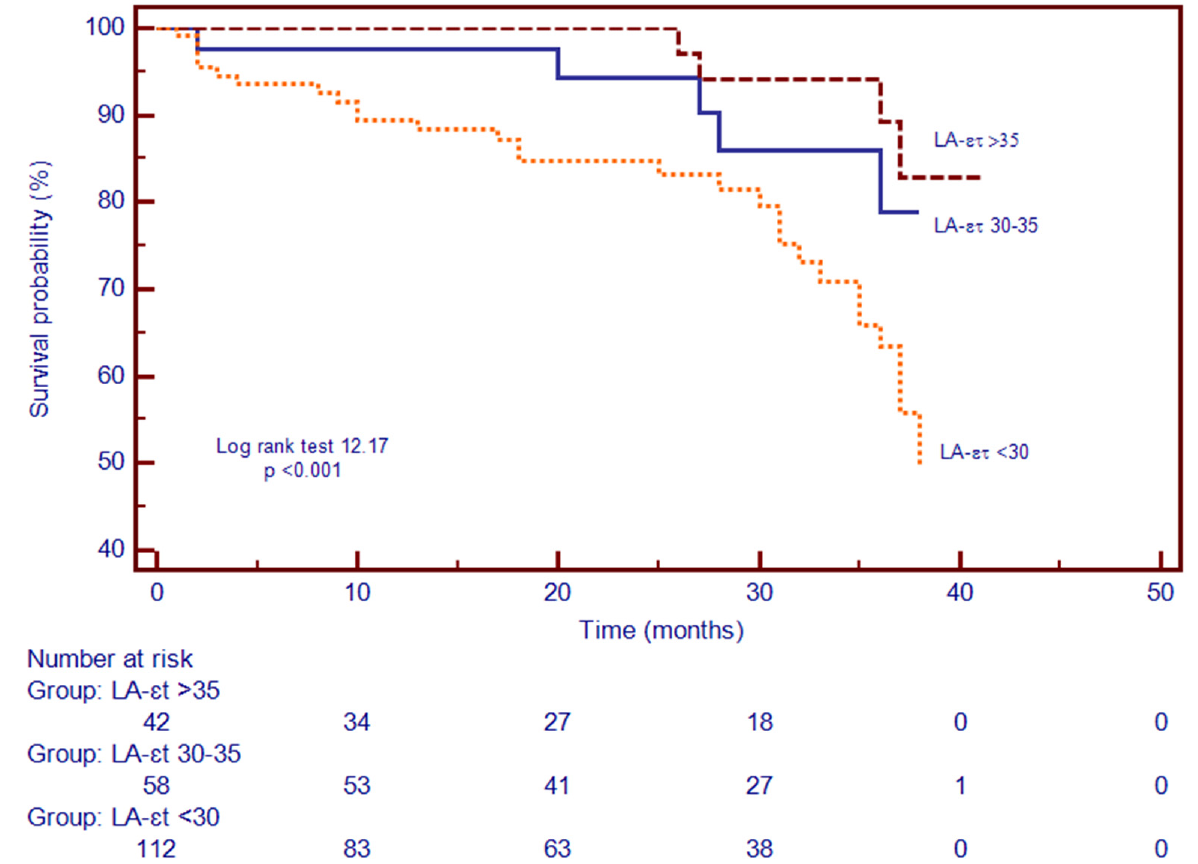
Figure 3. Kaplan–Meier curves for time to event analysis of LA- ε t . Abbreviations: LA- ε t , left atrial total strain.